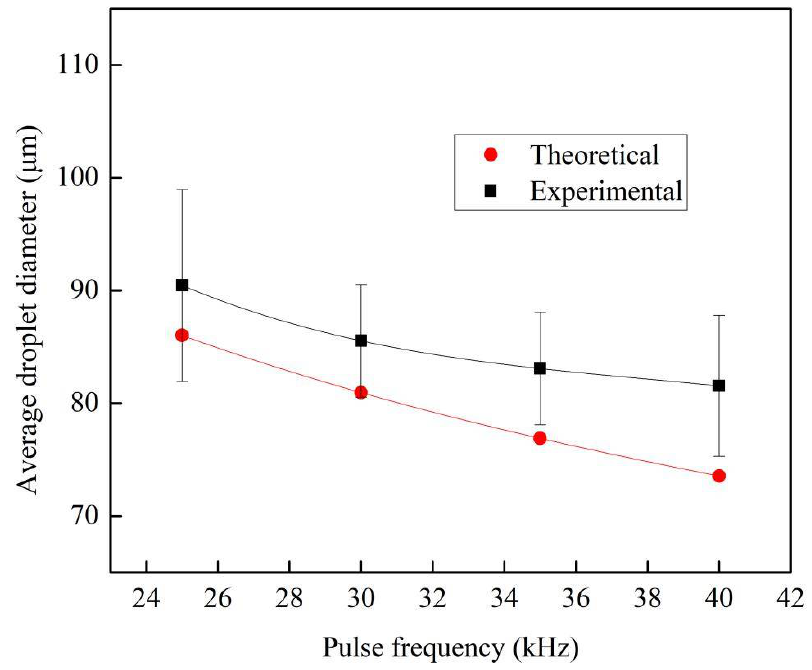
Figure 7. Average droplet diameters at the volume flow rate of 30 mL/h at different pulse frequencies of 25 kHz–40 kHz.